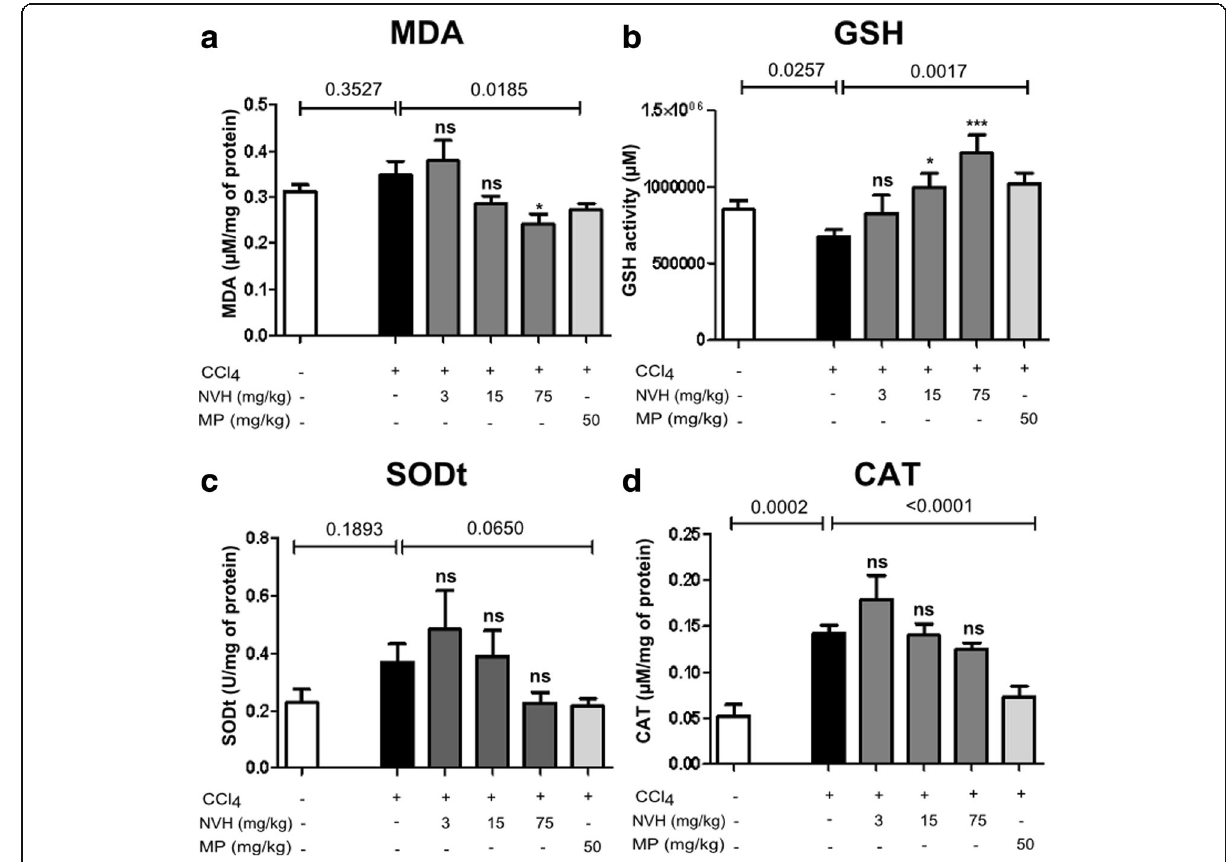
Fig. 9 Lipid peroxidation product and endogen antioxidant activity in CCl 4 -intoxicated mice. Mice were pretreated with the extract or methylprednisolone during 3 consecutive days. On the third day, acute liver injury was induced with carbon tetrachloride. Bar graphs represent, Malondialdehyde level ( a ), Glutathione content ( b ), Total superoxide dismutase ( c ) and Catalase ( d ) activity in mice. Data are expressed as mean ± Standard Error of the Mean. Significant Dunn ’ s post tests are indicated as *p < 0.05; **p < 0.01; ***p < 0.001; ns: non-significant. The p-value indi- cates the Mann-Whitney test. One experiment conducted, n = 10 in each group. MDA: Malondialdehyde; GSH: Glutathione; SOD: Superoxide dis- mutase; CAT: Catalase; MP: